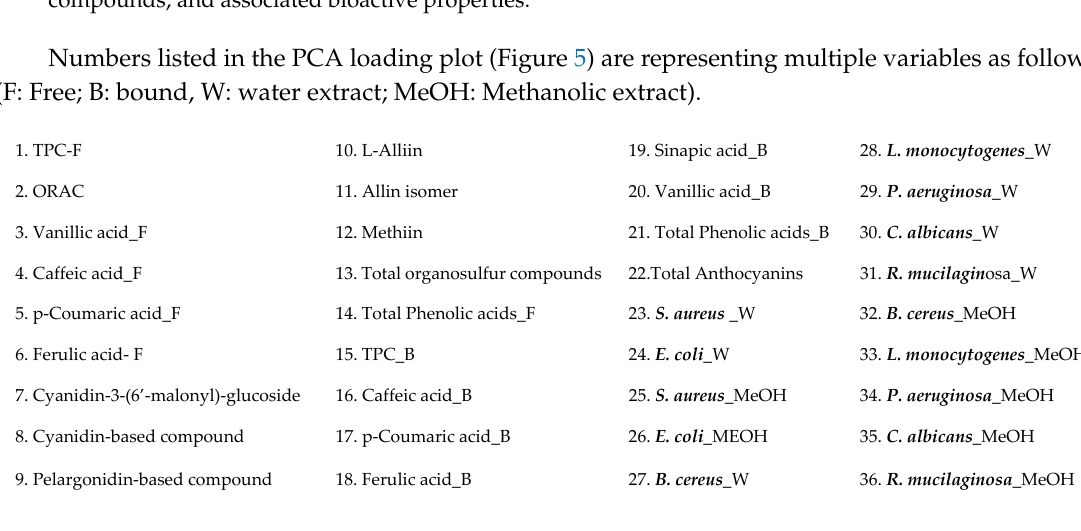
Figure 5. PCA loading plot describes all variables analyzed including polyphenols, organosulfur compounds, and associated bioactive